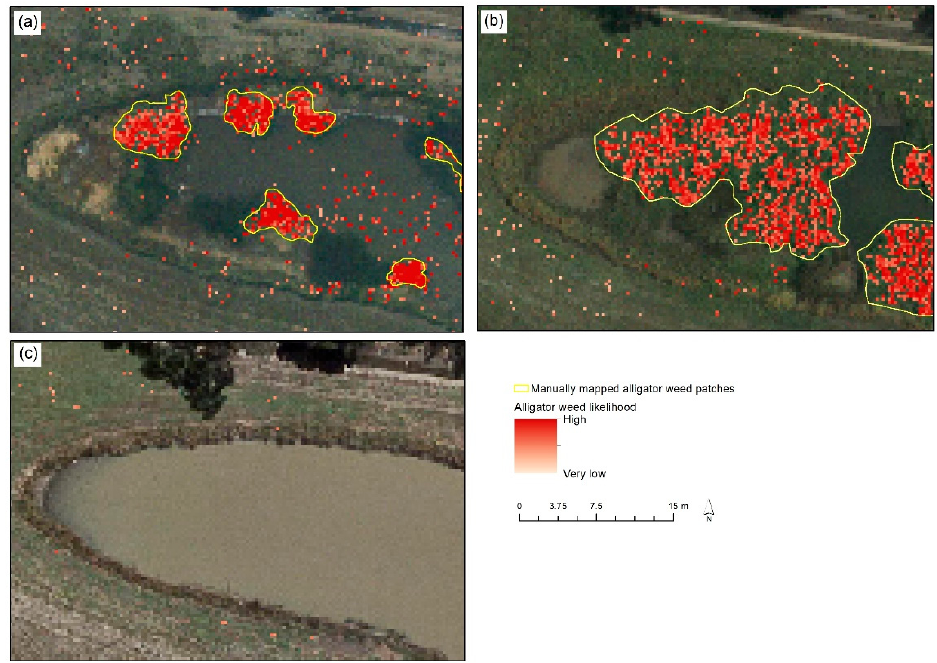
Figure 7. Site monitoring of alligator weed area over time in ( a ) the initial infestation stage during 2010, ( b ) peak coverage of alligator weed in 2011 and ( c ) 2016, following an alligator weed removal program at the site.